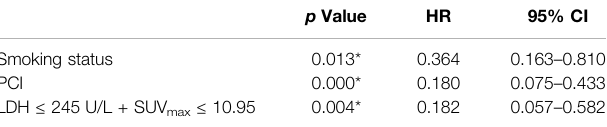
TABLE 5 | Multivariate analysis of overall survival in 54 patients with LD SCLC.